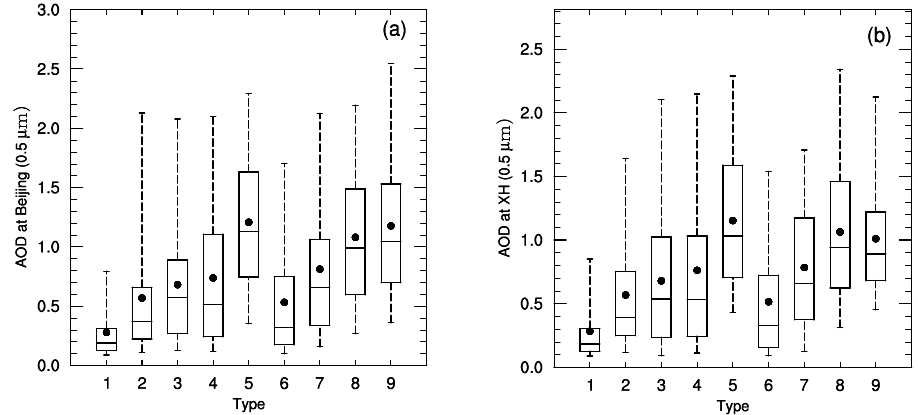
Fig. 7. AOD at AERONET stations in Beijing (a) and Xianghe (b) within the nine clusters. Solid dots denote the mean. The horizontal lines across the box are the median, first, and third quartiles, respectively, while the lower and upper crosses represent the 5th and 95th percentiles,